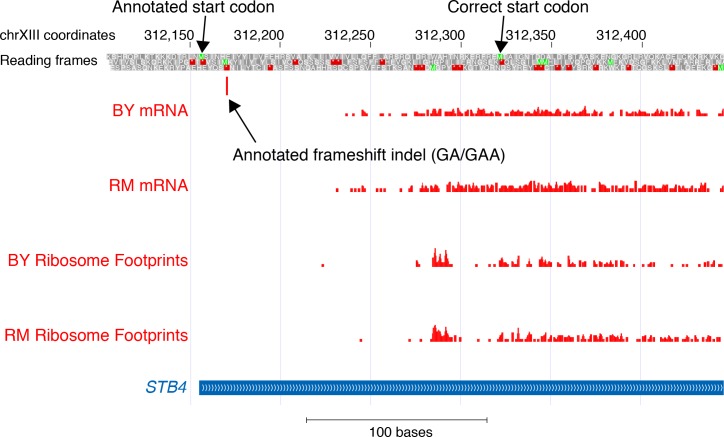
mRNA and translation at STB4.The figure shows the position of the first base in aligned reads from mRNA sequence and ribosome profile data (Albert et al., 2014a) in BY and RM. The annotated frameshift is located in a region without any mRNA or ribosome footprint reads. The annotated (presumably incorrect) and the likely correct start codon of STB4 are indicated.